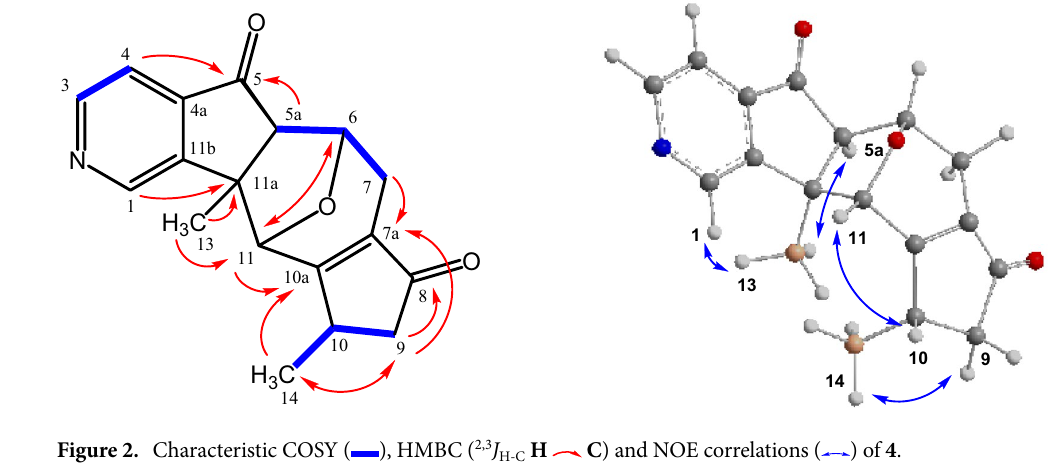
Figure 2. Characteristic COSY ( ), HMBC ( 2,3 J H-C H C ) and NOE correlations ( ) of 4 .